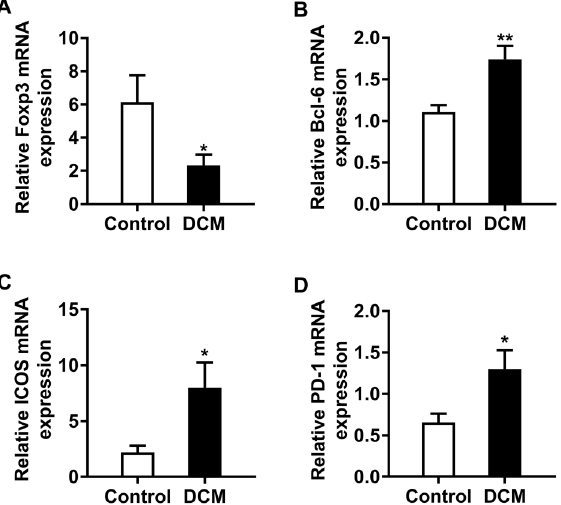
Figure 4. The levels of interleukin (IL)-6 ( A , n=16), tumor necrosis factor (TNF)- a ( B , n=30), IL-21 ( C , n=30), and IL-10 ( D , n=30) in plasma of patients with dilated cardiomyopathy (DCM) and healthy controls. Data are reported as means ± SE. *P o 0.05, **P o 0.01 compared to the Control group ( t